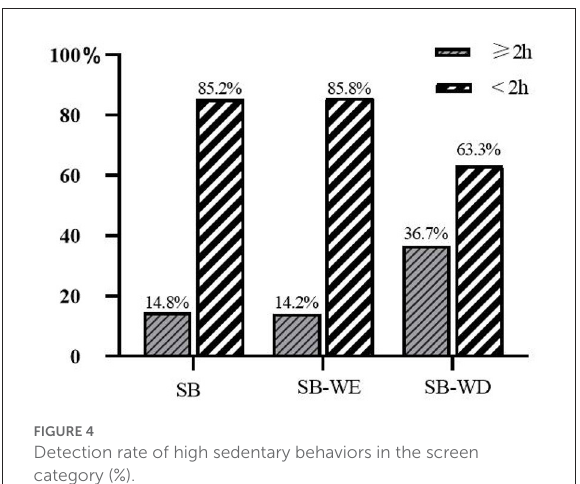
FIGURE4 Detection rate of high sedentary behaviors in the screen category (%).